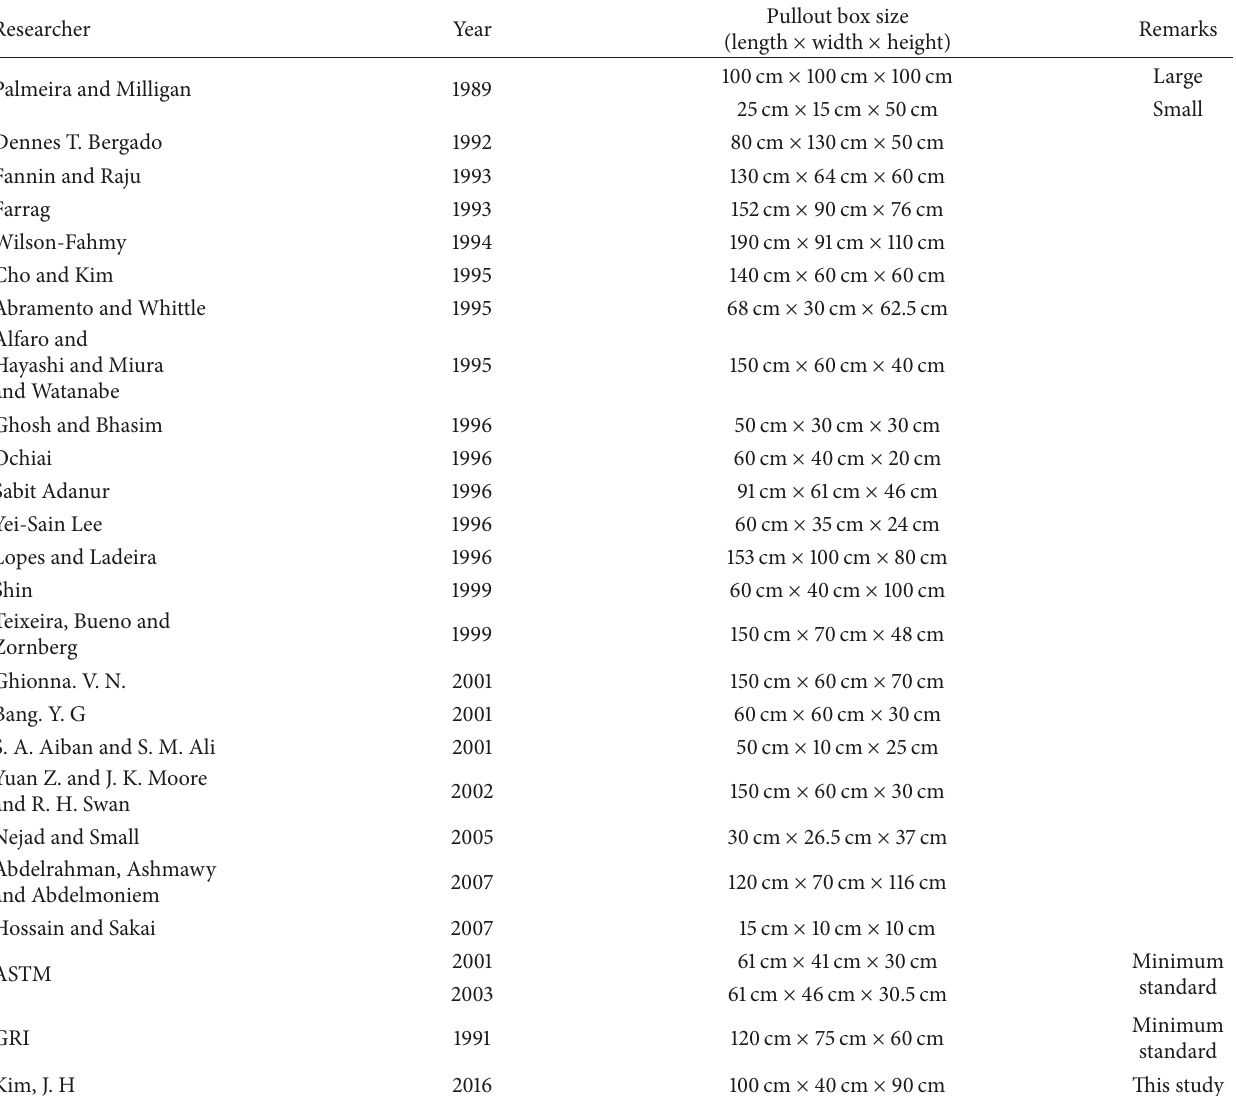
Table 1: Pullout test using pullout boxes of different size